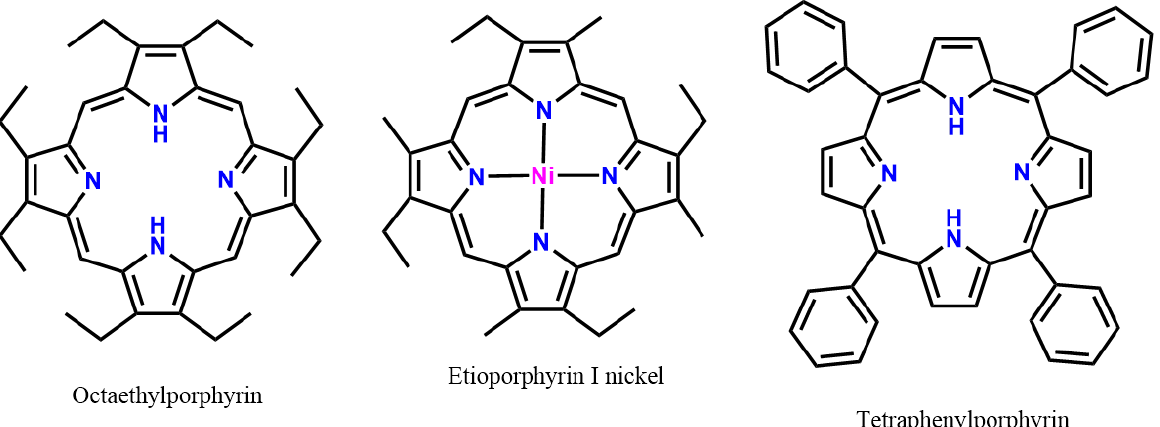
Figure 18. Molecular structures for octaethylporphyrin, tetraphenylporphyrin, and etioporphyrin I nickel, which elute the Aro-3 fraction.